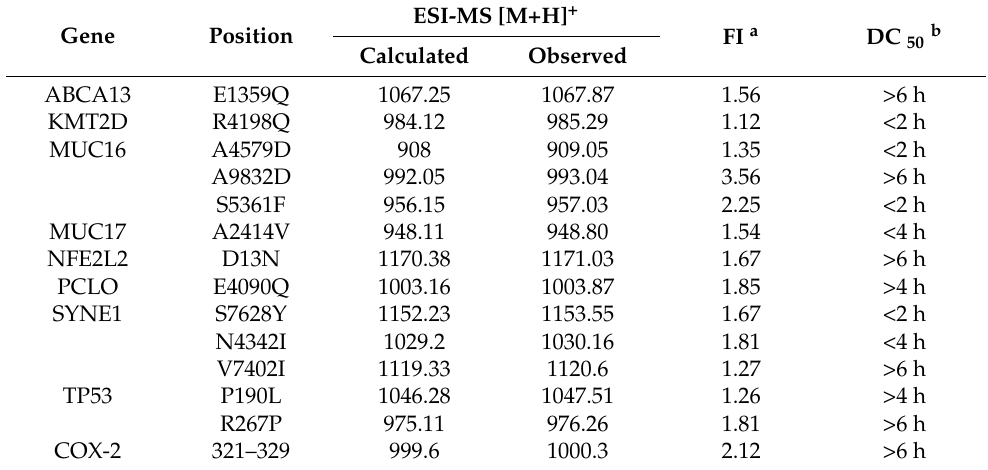
Table 2. The data of ESI-MS and the HLA-A*0201 binding affinity and stability of the mutant